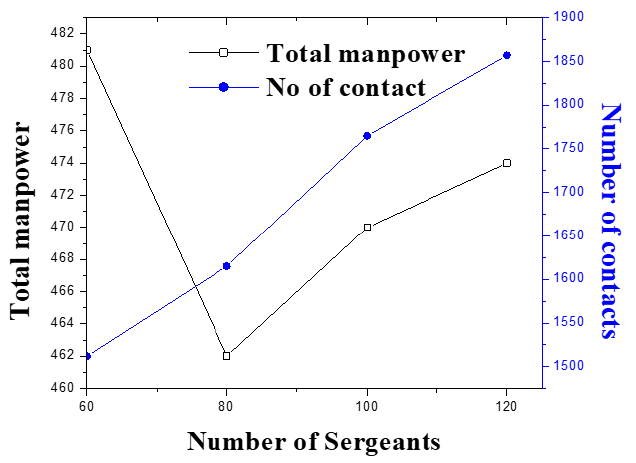
Figure 3. Number of contacts vs. total manpower.